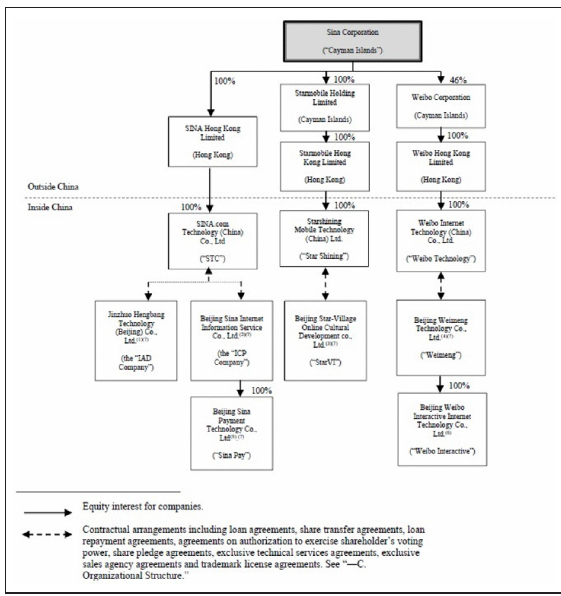
Figure 1: Sina’s Corporation Architecture. Source: Sina annual